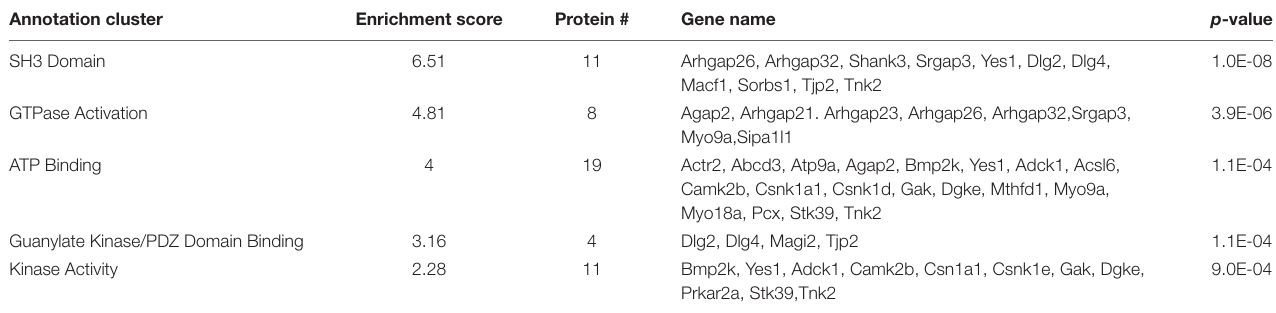
TABLE 3 | DAVID functional analysis of SIPs of similar interaction with WT SERT and SERT Ala56. Annotation